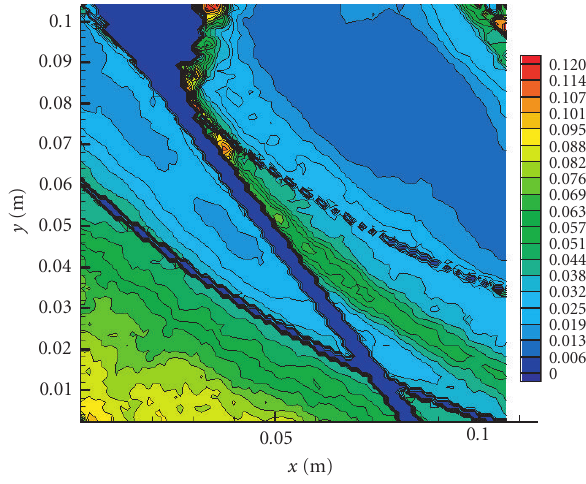
Figure 6: Velocity fluctuations in the passage